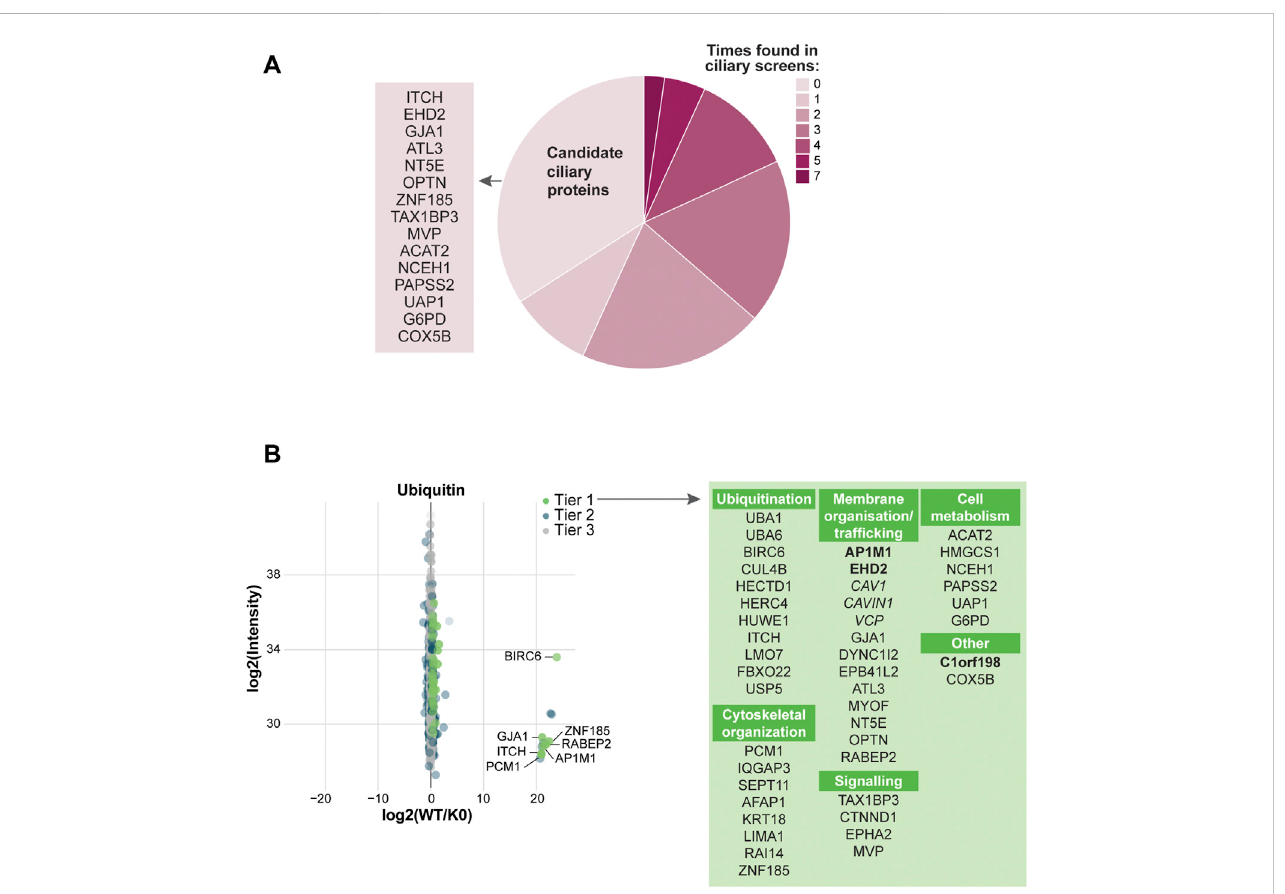
Analysis of UAP mass spectrometry results (A) Comparison of the signi fi cantly enriched proteins with our ciliary database. Most proteins were previously identi fi edinotherciliaryscreens,ofwhichPCM1,VCP,andDYNC1I2wereidenti fi edmostoften(darkpink).Theremainingproteinsareindicatedas ‘ Candidate ciliary proteins ’ on the left (B) MS analysis of the enriched proteins for the WT ubiquitin versus the K0 ubiquitin variant. Proteins are colored according to their signi fi cance tier and all Tier 1 signi fi cant proteins were grouped by function (green). The proteins related to clathrin-mediated endocytosis (bold) and non-clathrin-mediated endocytosis (italic) are marked. The complete list of identi fi ed proteins can be found in Supplementary Table